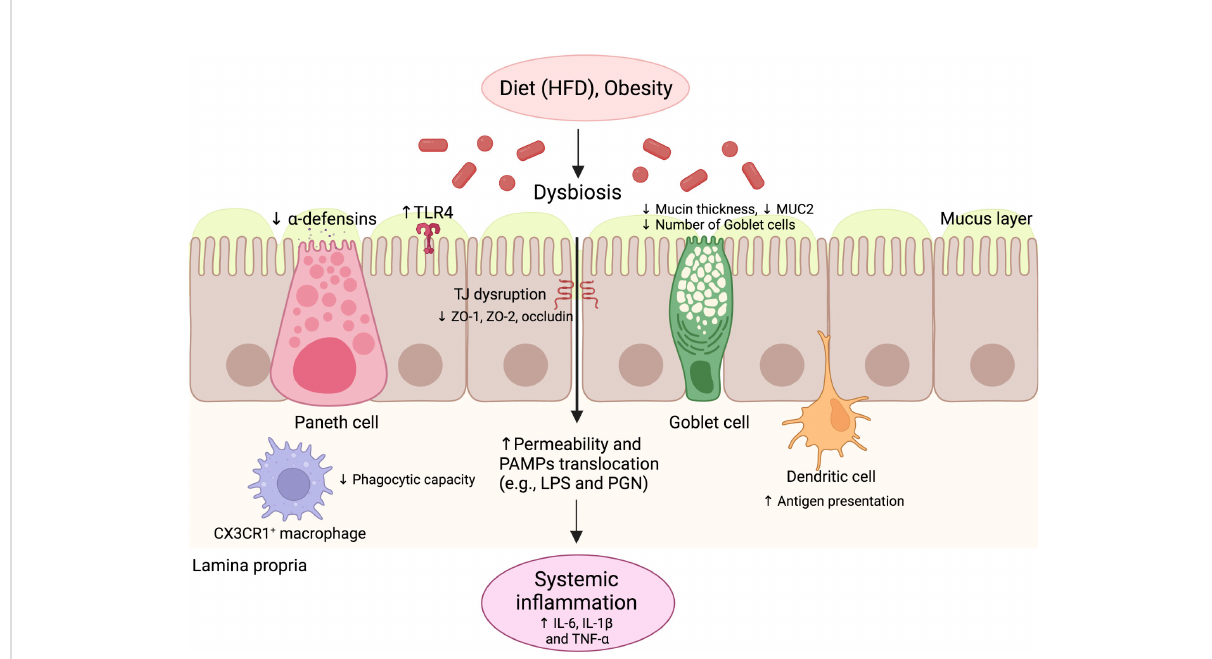
FIGURE 2 The innate immune response of the gut in NAFLD. Environmental factors such as diet and obesity promote dysbiosis in the gut microbiota, leading to increased levels of PAMPs and impaired intestinal barrier function. The intestinal barrier dysfunction is characterized by the impaired function of several cells, such as goblet cells and Paneth cells, with decreased production of mucin and antimicrobial peptides, respectively. TJ structure and composition disruption also occurs, characterized by reduced ZO-1, ZO-2, and occludin expression. Additionally, alterations of antigen-presenting cell function occur, including decreased phagocytic capacity and increased antigen presentation. These alterations promote increased intestinal permeability and the translocation of PAMPs, leading to increased serum levels of pro-in fl ammatory cytokines and systemic in fl ammation. HFD, High-fat diet; IL, Interleukin; LPS, Lipopolysaccharide; NAFLD, Nonalcoholic fatty liver disease; PAMP, pathogen-associated molecular pattern; PGN, Peptidoglycan; TLR, Toll-like receptor; TNF, Tumor necrosis